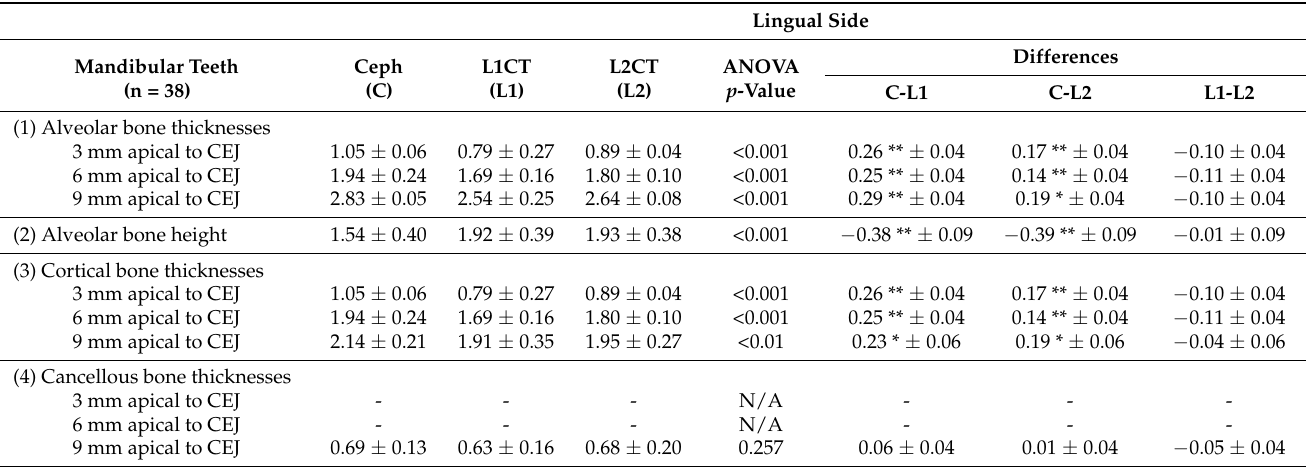
Table 2. Comparisons of lingual alveolar bone between Ceph, L1CT, and L2CT. Lingual